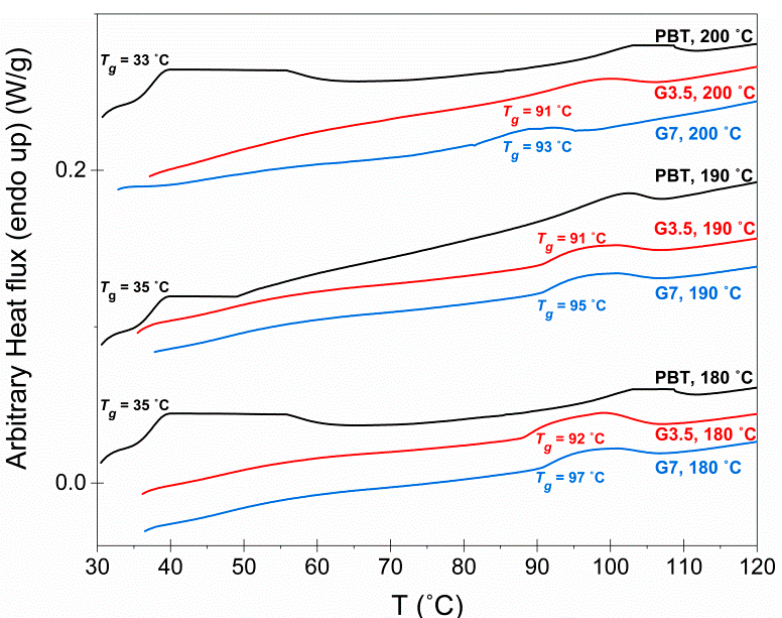
Figure A1. Differential scanning calorimetry (DSC) curves of the neat PBT powder and vitrimers at the end of the solid-state repolymerization ( t = 3 h) at three different temperatures (180, 190, 200 °C).